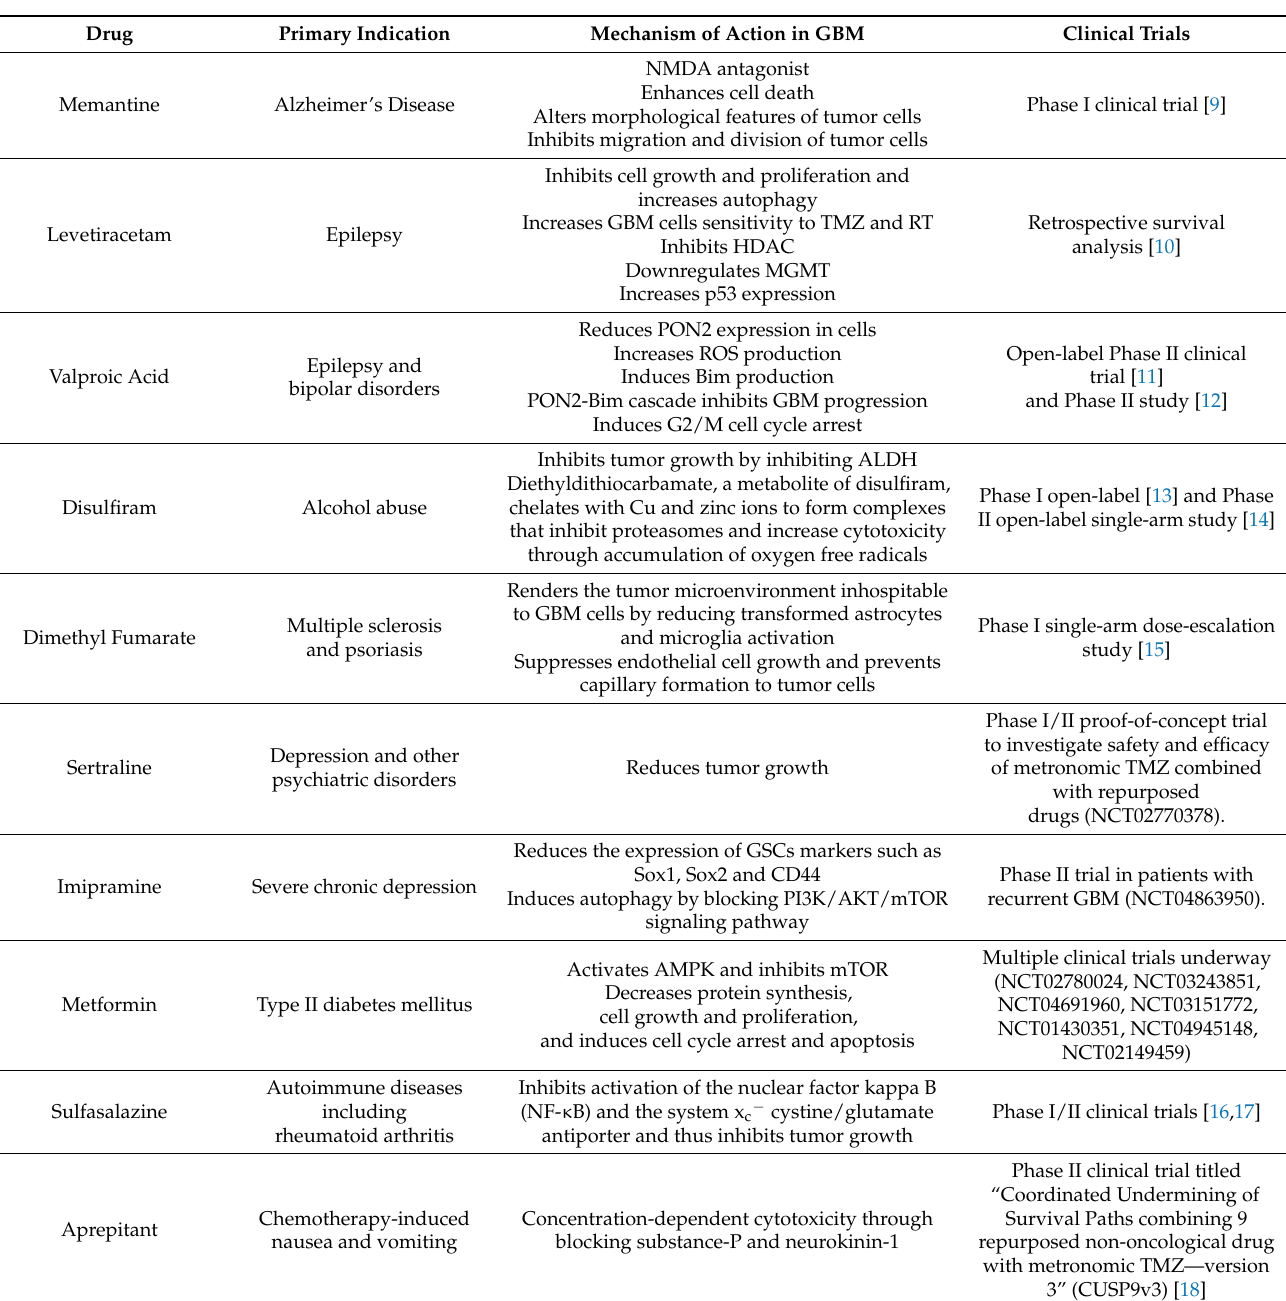
Table 1. Drugs in the clinical trial phase. Acronyms used: AKT: v-akt murine thymoma viral oncogene homolog; ALDH: aldehyde dehydrogenase; CMV: cytomegalovirus; FGF: fibroblast growth factor; GBM: glioblastoma; HDAC: histone deacetylases; MGMT: O6-methylguanine-DNA methyltransferase; MMP-2: matrix metalloproteinase-2; mechanistic target of rapamycin; NMDA: N-methyl-D-aspartic acid; PDGF: platelet-derived growth factor; PI3K: Phosphatidylinositol-3-kinase; PON: paraoxonase; ROS: reactive oxygen species; RT: radiation therapy; TGF- β : transforming growth factor- β , and VEGF: vascular endothelial growth